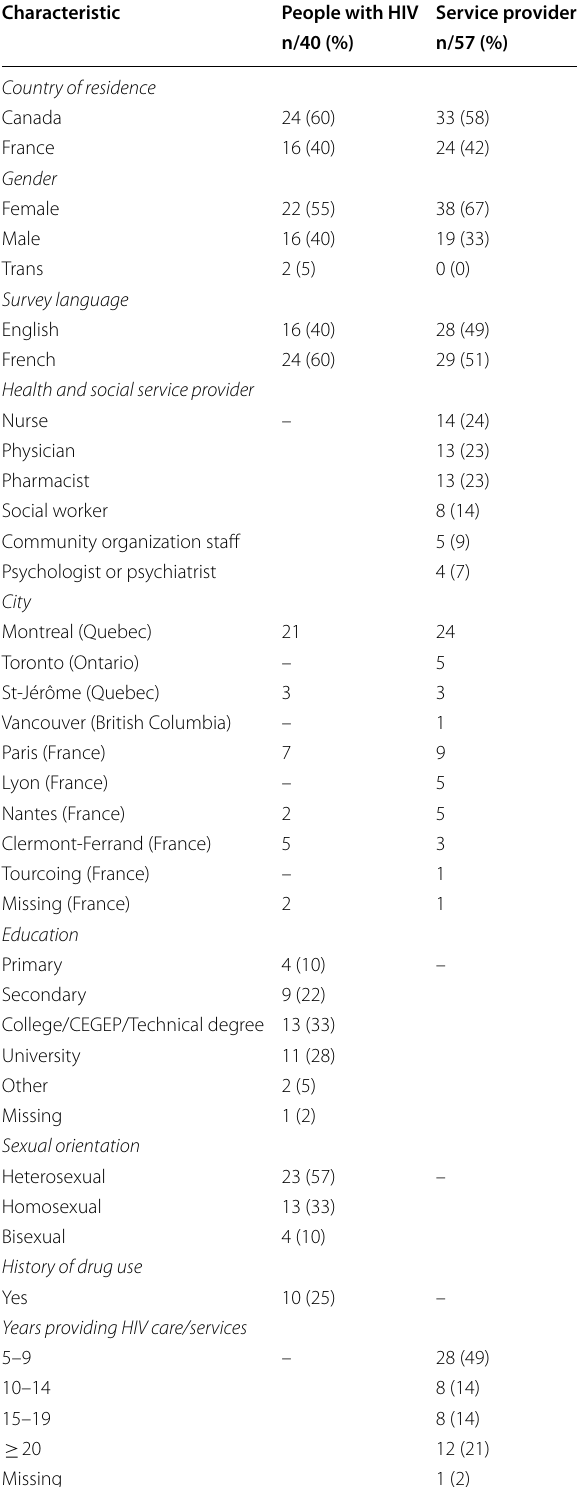
Table 2 Sociodemographic characteristics of the